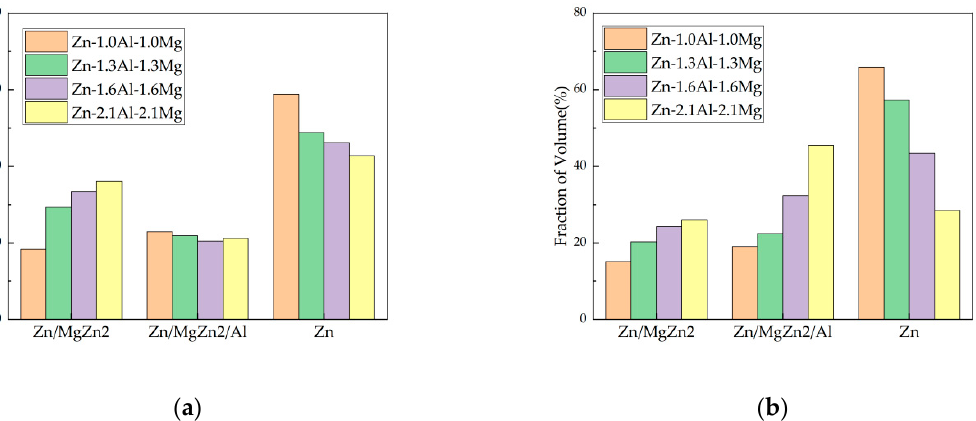
Figure 6. Statistical results of phase distribution of different coatings ( a ) cross-section, ( b ) surface section.